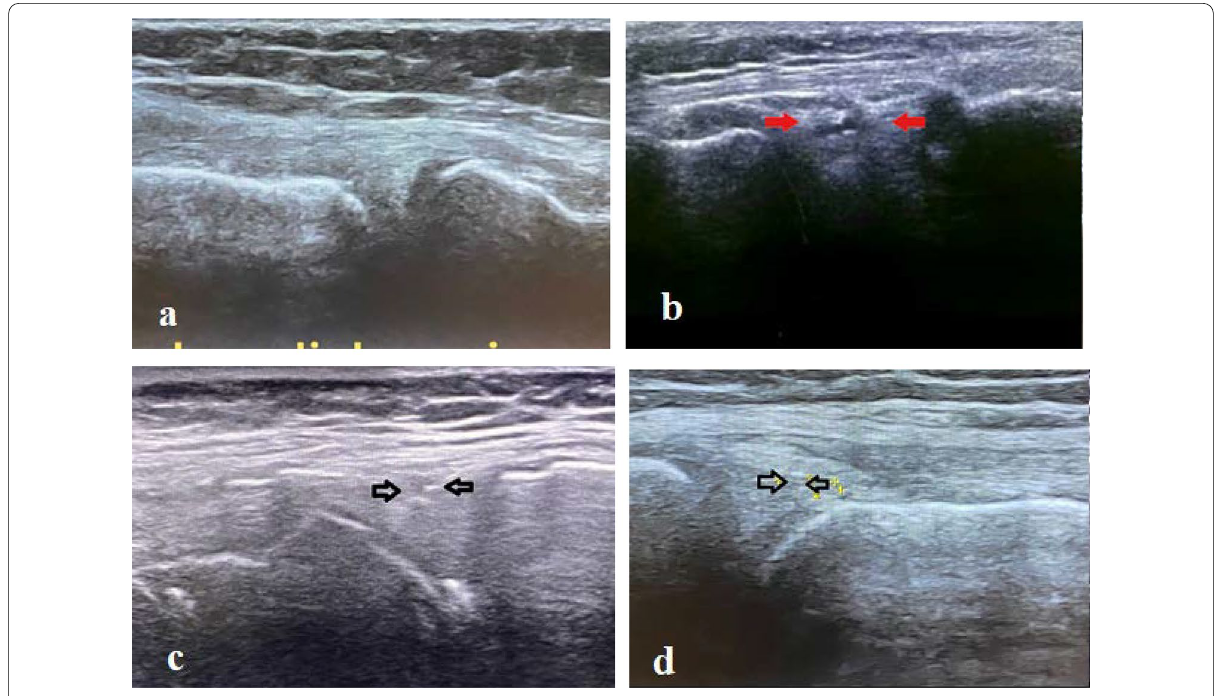
Fig. 1 a Normal medial meniscus, b – d medial meniscus